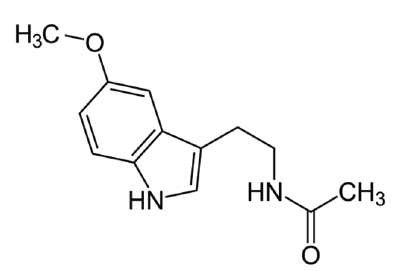
Figure 1. Structure of